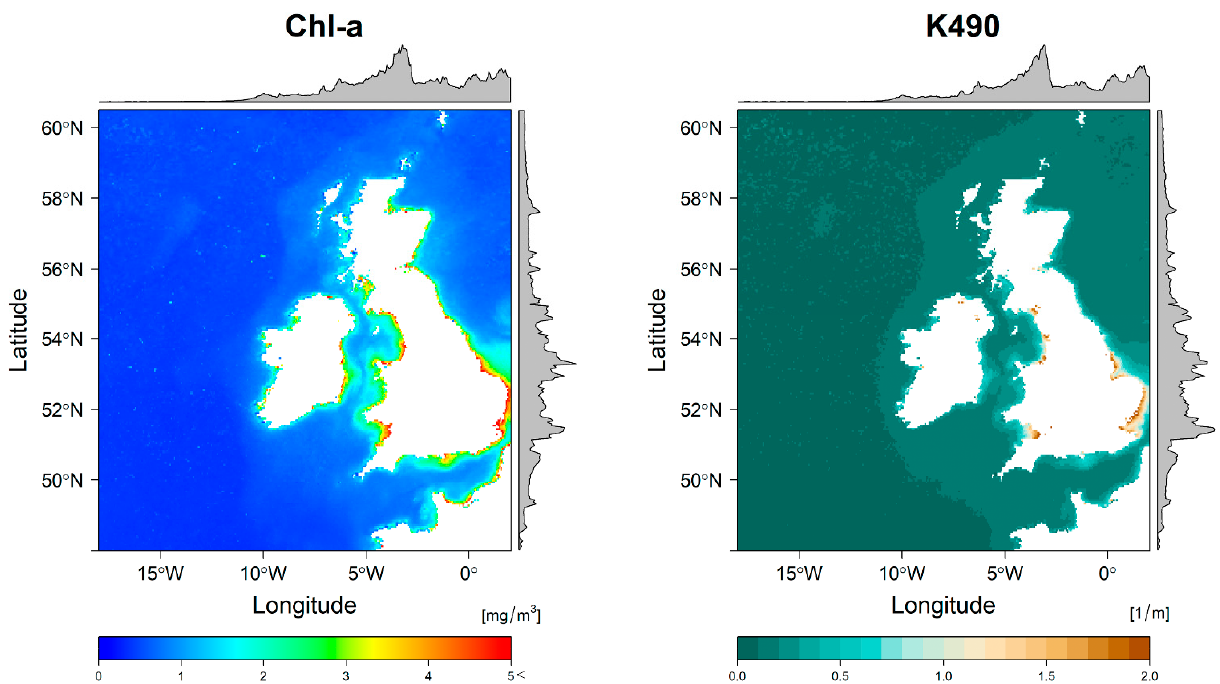
Figure 2. Chl-a and K490 climatologies derived from the nineteen-year OC-CCI dataset (1998– 2016).